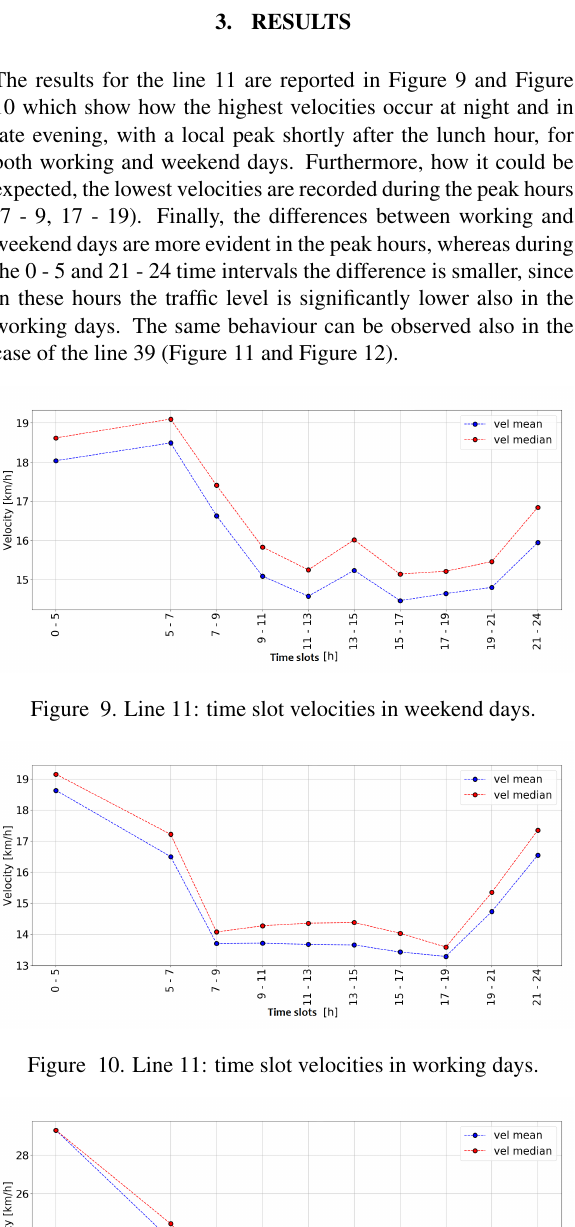
Figure 12. Line 39: time slot velocities in working days.